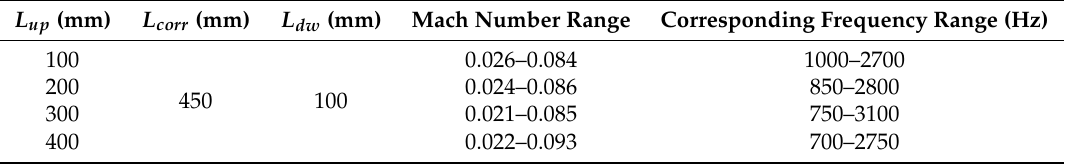
Table 16. Mach number and corresponding frequency range (Hz) for pipe systems in Case b-III.